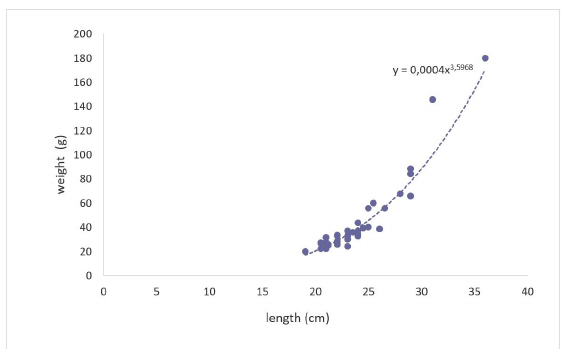
Figure 1. Length-weight relationship of tuvira, Gymnotus spp., from a commercial “bait house” of Mato Grosso do Sul, Brazil.